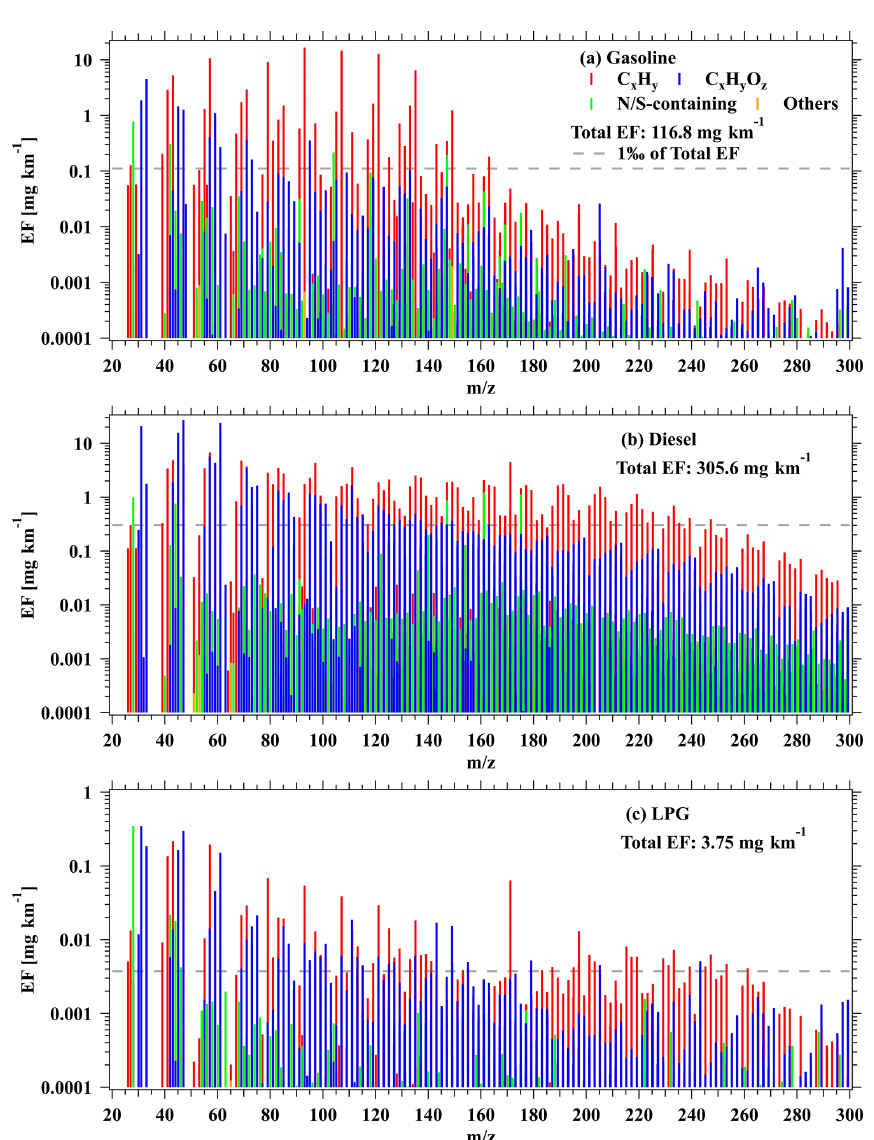
Figure 5. The determined average mileage-based emission factors of VOC species measured by the PTR-ToF-MS from (a) gasoline, (b) diesel, and (c) LPG vehicles. The dashed gray lines represent 1‰ of total VOC emission